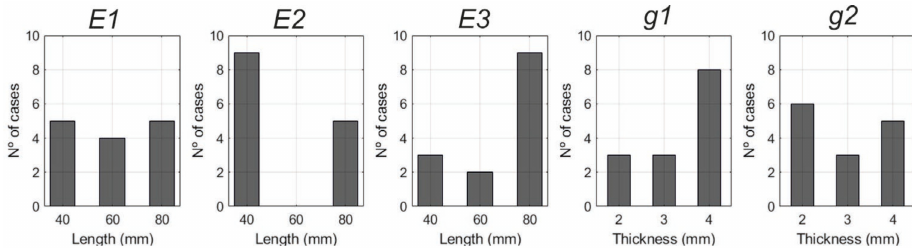
Figure 14. Variables values of frequent input data in best performance networks—T1.